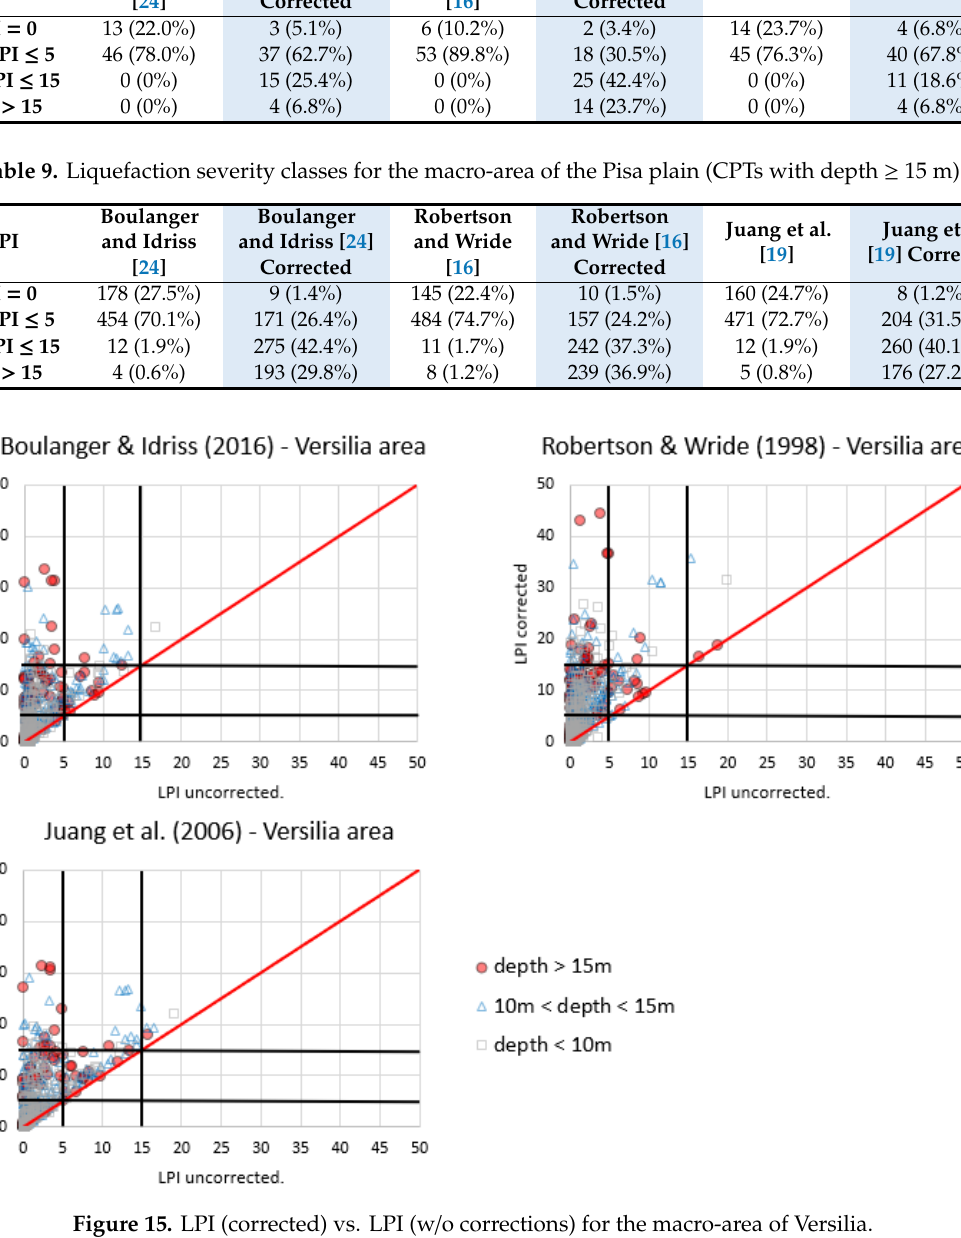
Figure 15. LPI (corrected) vs. LPI (w/o corrections) for the macro-area of Versilia.